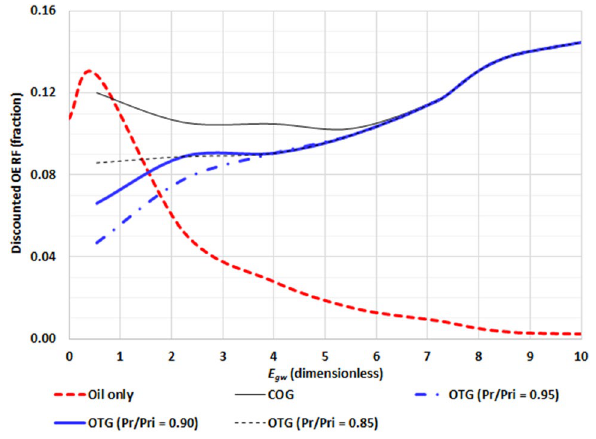
Fig. 8 Discounted OE RF versus E gw (10% discount rate) with verti- cal oil producers. Note that E gw = 0 refers to the undersaturated